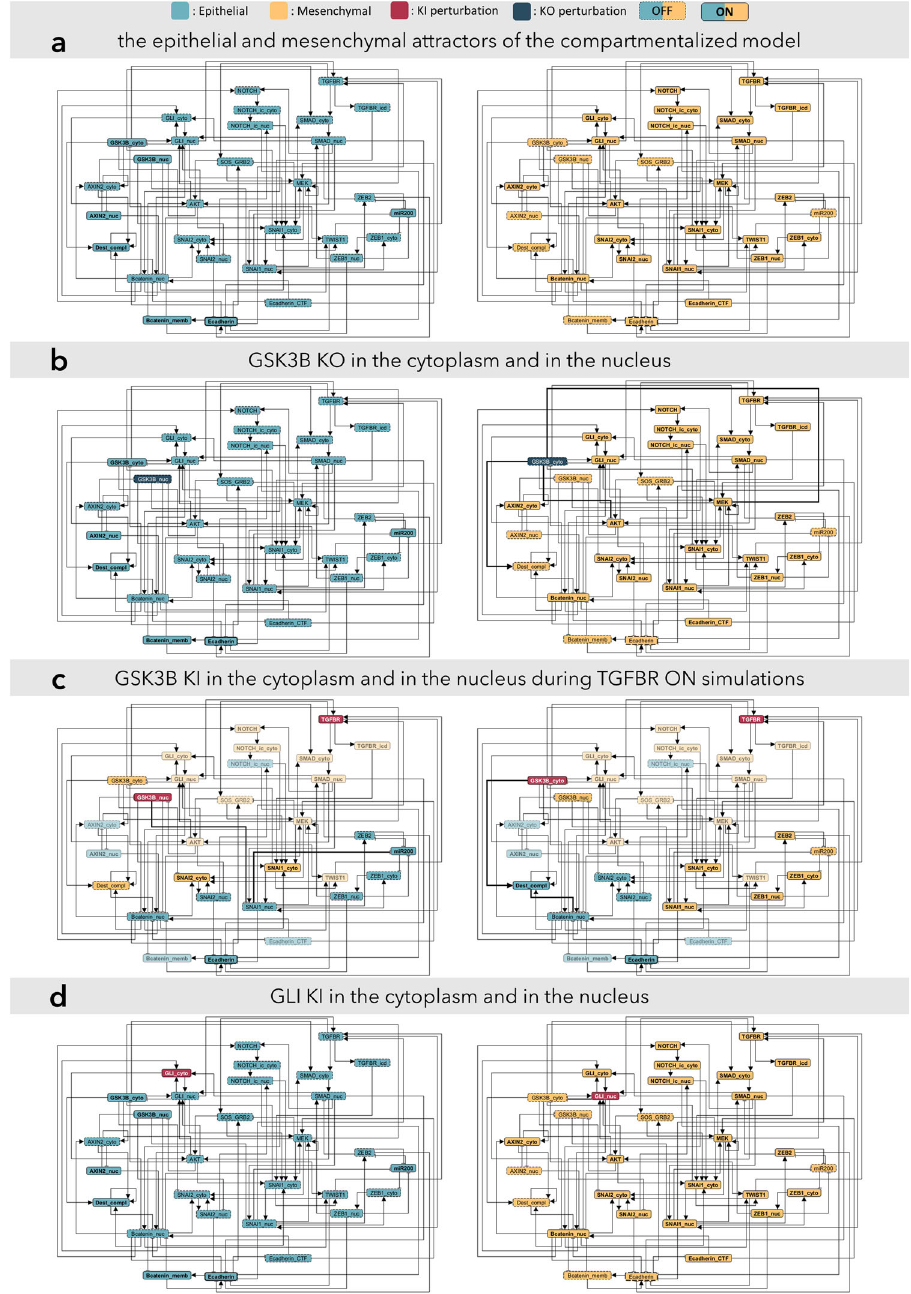
Fig. 4 Attractors of the compartmentalized model showing localization-speci fi c functions of GSK3B and GLI. a The attractors corresponding to the epithelial and mesenchymal state can be seen on the left and right respectively. During the dynamic simulations, perturbations were introduced to the initial epithelial state. b In case of the TGFBR OFF simulations the cytoplasmic KO of GSK3B resulted in EMT, while the nuclear perturbation had no effect. The signal from GSK3B_cyto KO propagated through the loss of the Dest_compl and the activation of AKT and MEK. c During TGFBR ON simulations both the KI of the cytoplasmic and nuclear node of GSK3B inhibited the TGFB mediated EMT. The nuclear perturbation had a greater inhibitory effect by preventing the loss of miR200 and consequently the activation of ZEB1 and ZEB2. The nuclear perturbation also led to the inhibition of SNAI2_nuc and Bcatenin_nuc, despite the loss of the Dest_compl and the activation of SNAI2_cyto compared to the cytoplasmic perturbation. GSK3B_cyto functions both to stabilize the epithelial state and to inhibit TGFB mediated EMT, whereas GSK3B_nuc functions speci fi cally to inhibit TGFB mediated EMT d TGFBR OFF simulations show that the nuclear perturbation of GLI led to EMT, while the cytoplasmic perturbation alone was insuf fi cient to destabilize the epithelial state. As part of a transcription factor family, the GLI proteins exert their main function in the nucleus and if sequestered in the cytoplasm, GLI2 gets truncated into a repressor form that further decreases transcriptional activity. The compartmentalized model reproduced these localization-speci fi c